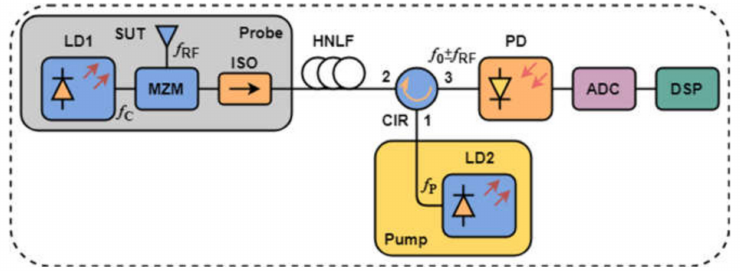
Figure 22. Basic structure for an IFM based on SBS. LD—Laser diode; SUT—Signal under